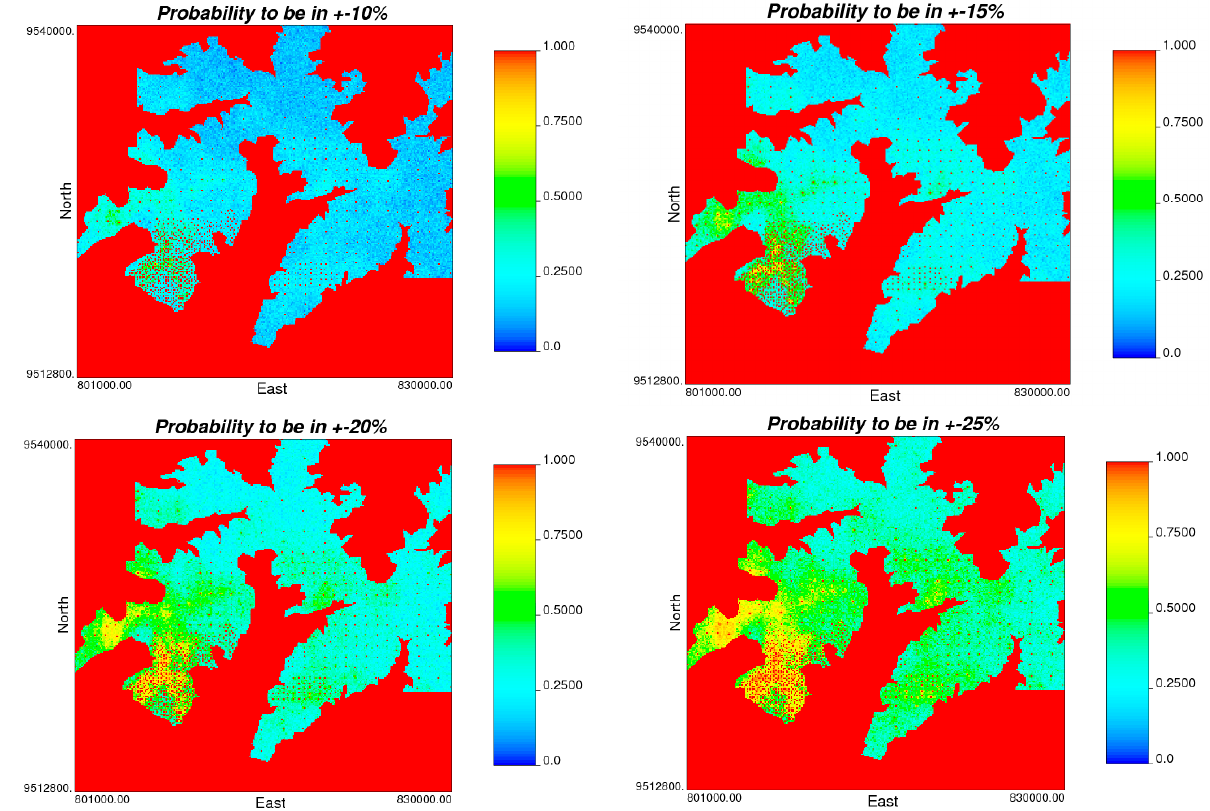
Figure 16. Maps of probability for confidence intervals of 90%, 85%, 80%, and 75%.